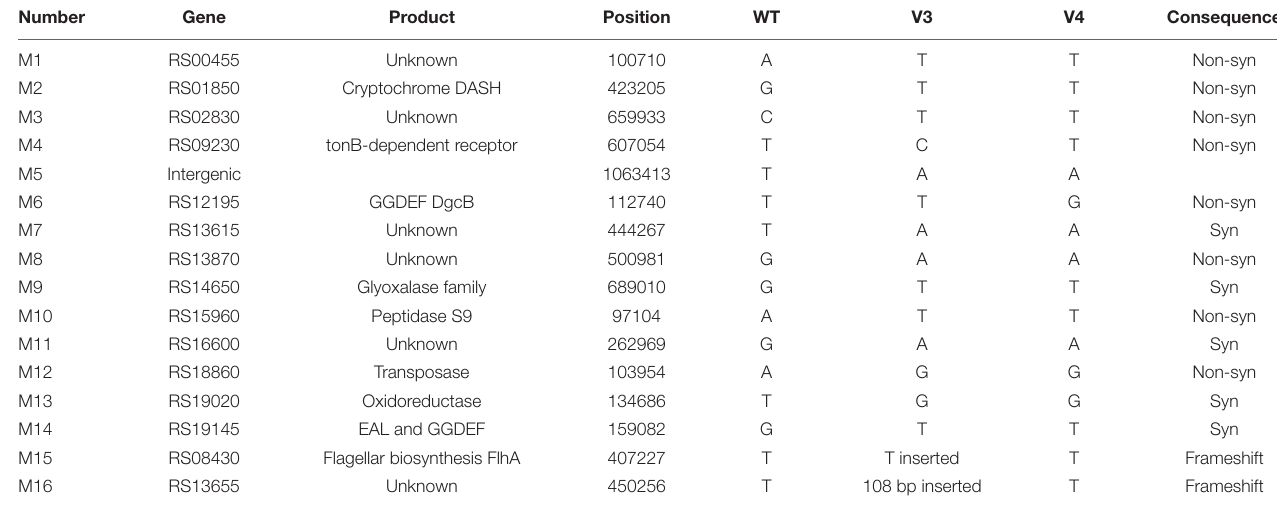
FIGURE 2 | Spontaneous mutation in the wspF-like gene causes the wrinkled phenotype in the majority of wrinkled variants. (A) Swimming motility of three wrinkled variants complementing the wspF-like gene was examined by culturing on semisolid 2216E agar plates containing 15 µ g/mL chloramphenicol for 20 h. (B) Cellulose production was examined and measured using Congo red for three wrinkled variants complemented with the wspF-like gene. Statistical significance (* P < 0.05; NS, not significant) is indicated with asterisks. TABLE 2 | Mutations revealed by whole-genome re-sequencing of the two wrinkled variant strains isolated from the biofilms of wild-type P. lipolytica .